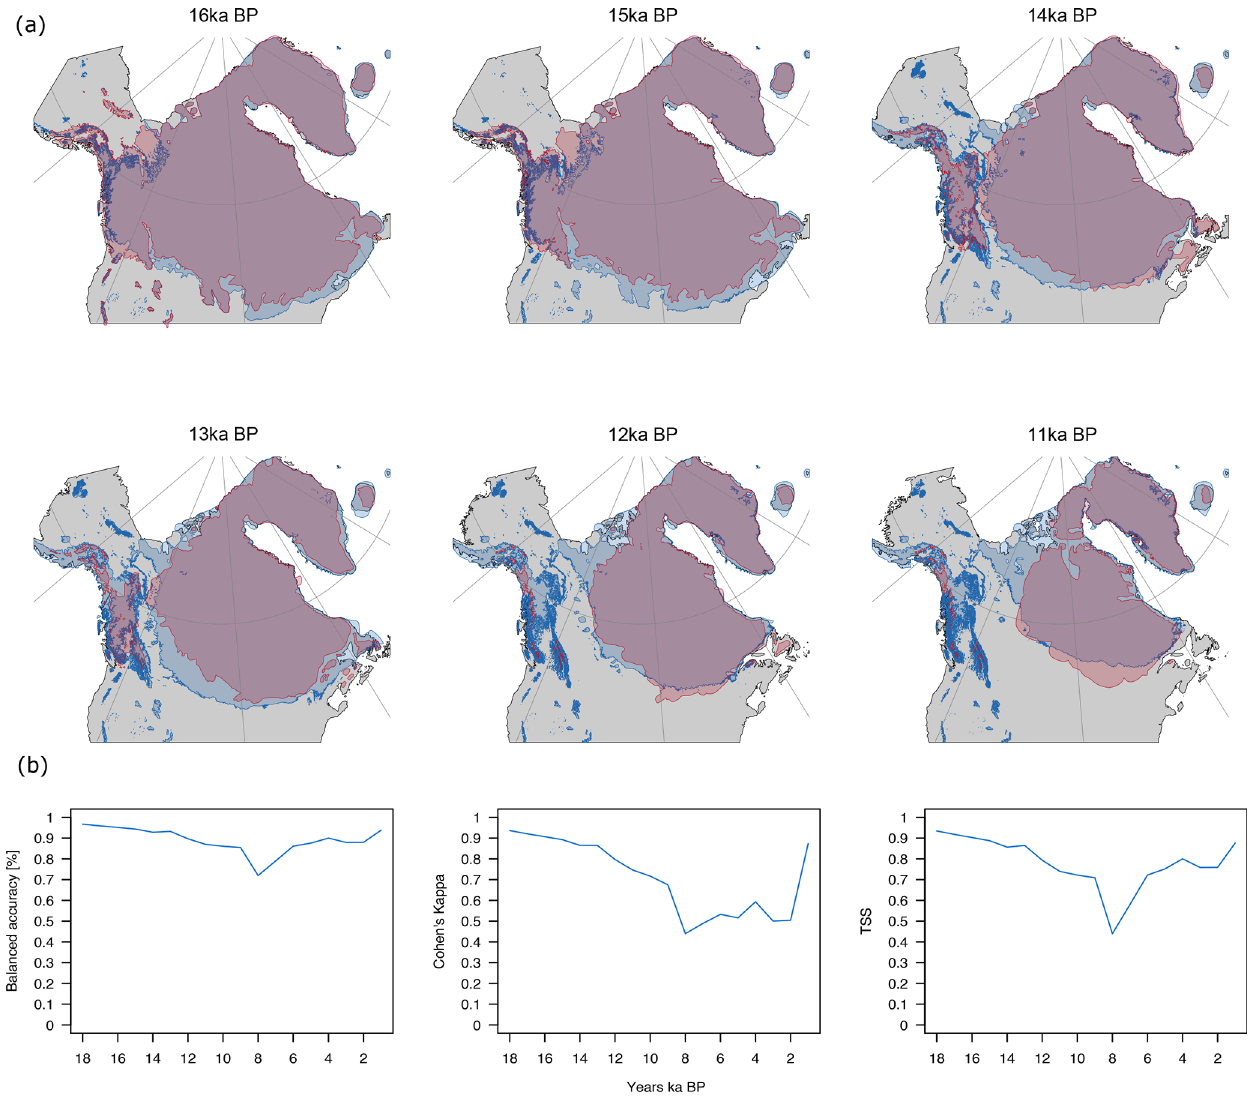
Figure 6. (a) Comparisons of estimated glacial extents of the Laurentide ice sheet from 16 to 11ka. Blue delineates the interpolated ice sheet extent from CHELSA-TraCE21k, and red shows the estimated extent from Dyke (2004). While the retreat of the main Laurentide ice sheet is similar in both estimations, the Cordilleran ice sheet covering the Rocky Mountains retreats faster in the estimations by Dyke (2004) compared to CHELSA-TraCE21. (b) Performance comparison using three different metrics (balanced accuracy, Cohen’s kappa, and true-skill statistic) from a comparison of CHELSA-TraCE21k and Dyke